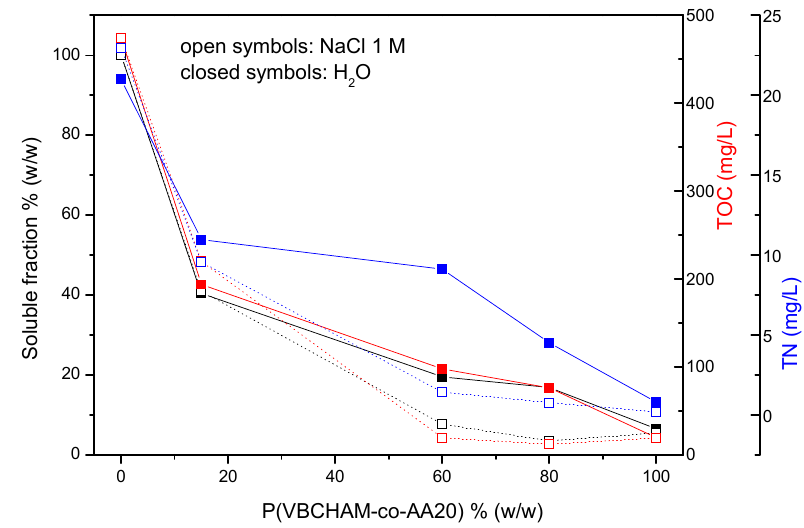
Figure 6. Influence of the P(VBCHAM ‐ co ‐ AA20) % ( w / w ) content of P(SSAmC 16 ‐ co ‐ GMA20)/ P(VBCHAM ‐ co ‐ AA20) 40/60 w / w polymeric coatings on the soluble fraction (%) and the TOC, TN values of the solutions after immersion of the coatings for 7 days in ultra ‐ pure water and aqueous NaCl 1 M solutions. Apart from pure copolymers, all other coatings were cured at 120 °C.